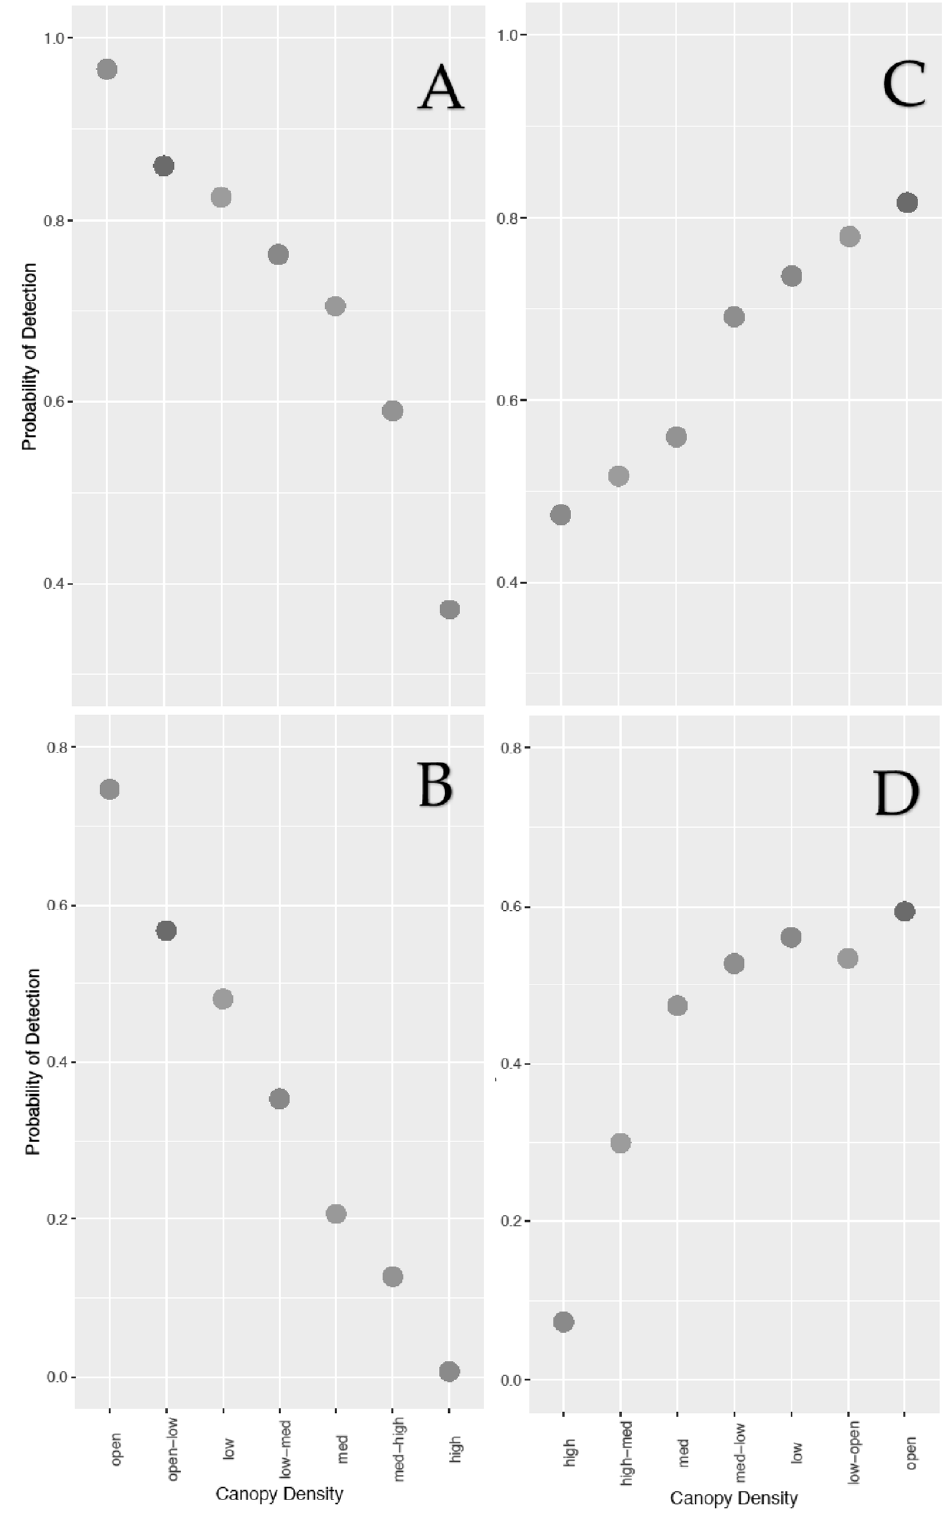
Figure 3. Scatterplots showing the relationship between increasing canopy density and probability of detection for both camera angles with manual detection. ( A ) Canopy vs. 90° camera angle for TIR data, ( B ) canopy vs. 90° camera angle for RGB data, ( C ) canopy vs. 45° angle for TIR data, ( D ) canopy vs. 45° angle for RGB data. The x axes for A and B (90° angle) and C and D (45° angle) are in opposite directions to represent the direction the test subject walked from point to point.